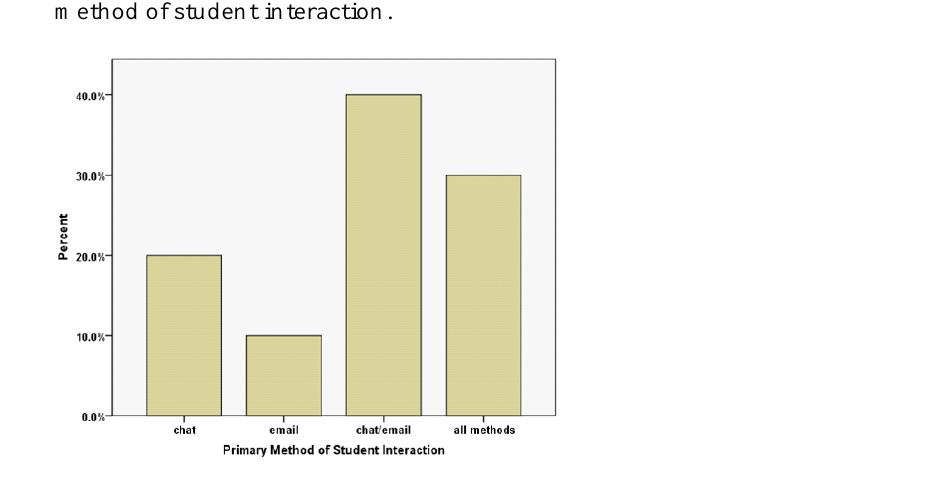
One-Way Analysis To Examine the Differences Between Persistence Rates (Based on the Primary Method of Instructor Interaction) SS df MS F P-Value Between 0.004 2 Groups Within Group Total Ϝ (2,7) = 0.255 ; Р >